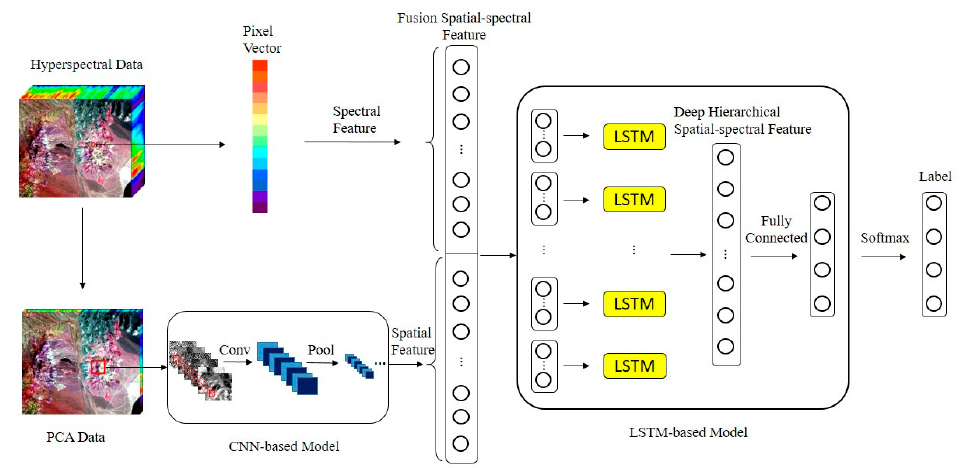
Figure 1. Architecture of HSS-LSTM for mineral identification using hyperspectral data.